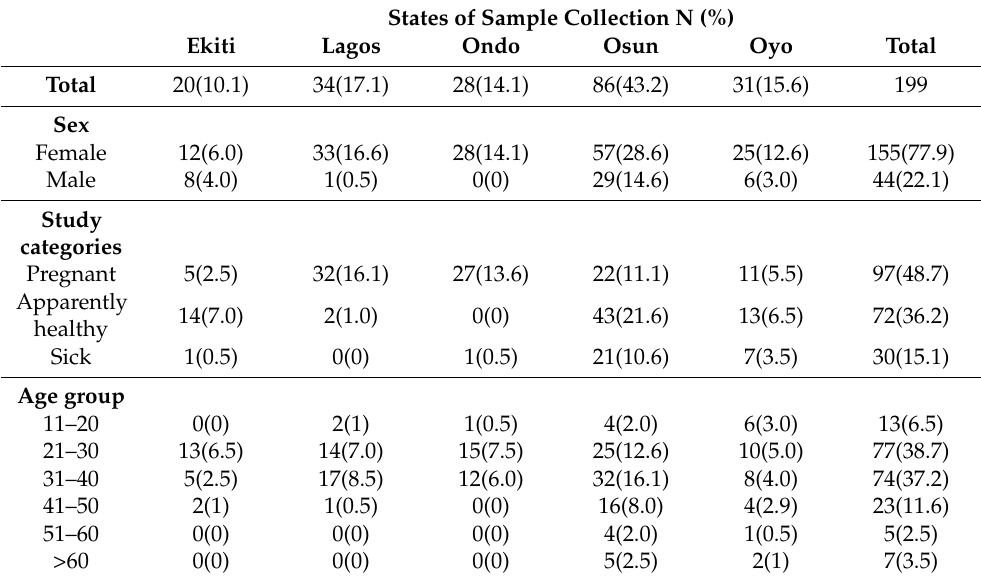
Table 1. Overview of the characteristics of the